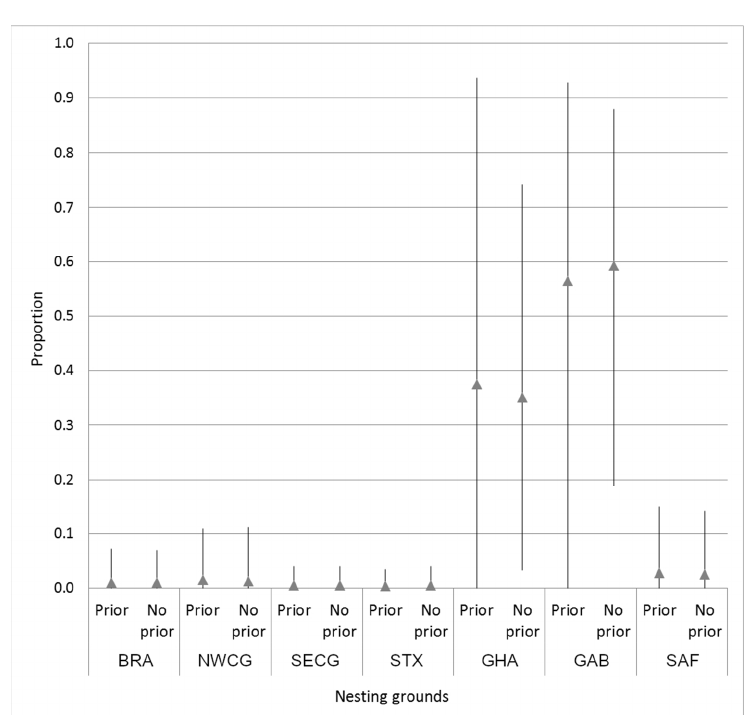
Figure 2. Mean estimated stock contributions from Atlantic leatherback rookeries to the combined UR, BA, and SBR regional SWAO foraging aggregation using priors (weighted by rookery size) and no priors (equal contributions). Credible intervals (95%) are indicated. Abbreviations correspond with Figure 1. The log-likelihood ratio test (LRT, “anova” function in the “nlme” package [68]) was employed to test for di ff erences in the average number of strandings per year and month. The statistical analysis was performed with RStudio 1-4.11 [69]. The Kernel density map was created with ArcGIS 10.3 [70].